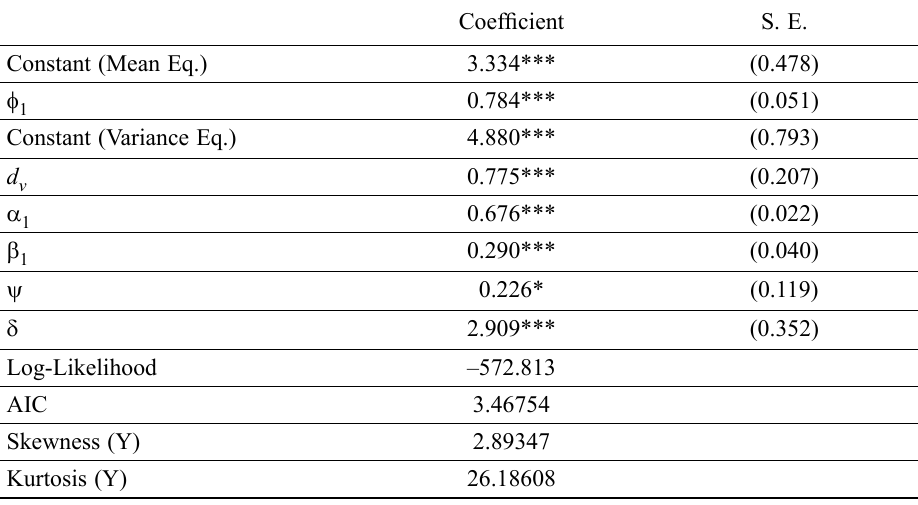
Table 4. Maximum likelihood estimate of ARMA-FIGARCH model: 1982(2)–2009(12) Coefficient S. E.